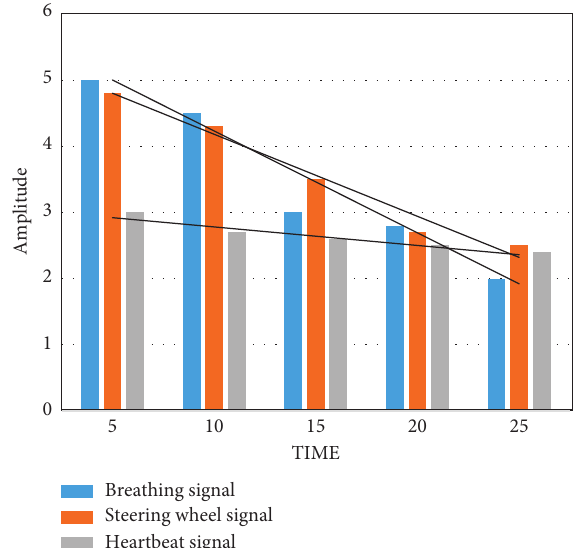
Figure 12: Physiological signal and steering wheel signal change amplitude.